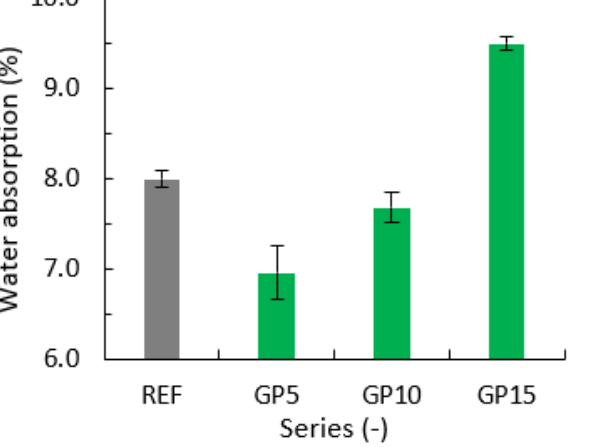
Figure 4. Water absorption for the reference series and series with a partial replacement of cement with granite powder (GP).